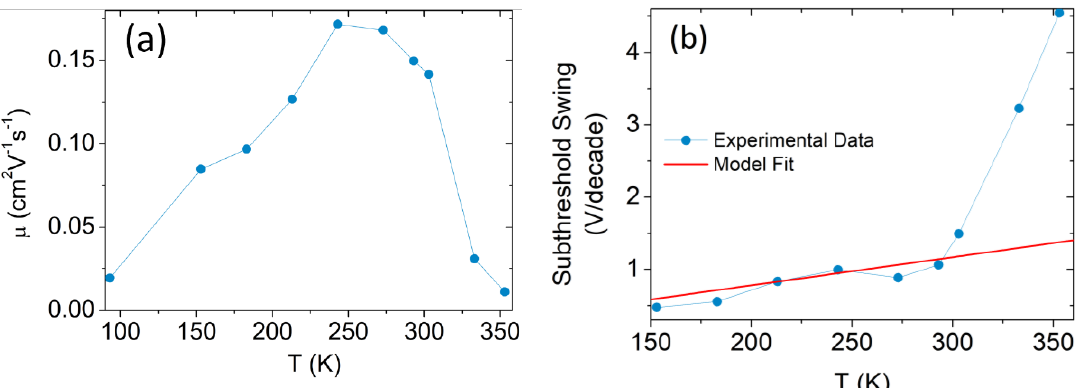
Figure 6. Temperature dependence of ( a ) mobility per unit voltage 𝜇 𝐵 and ( b ) subthreshold swing.